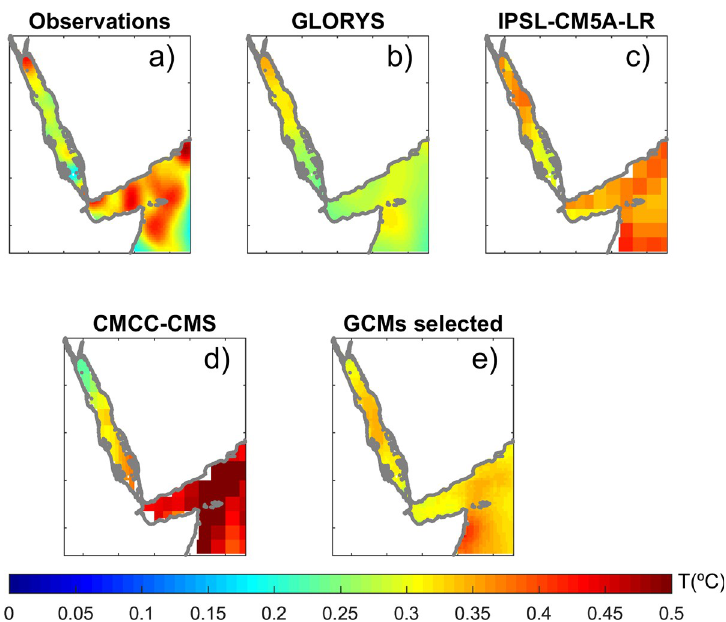
Fig 5. Interannual std of sea surface temperature from (a) observations, (b) the GLORYS reanalysis, (c) a GCM with good skills (IPSL-CM5a-LR;), (d) a GCM with low skills (CMCC-CMS;) and (e) the average of selected GCMs (see “Model selection”